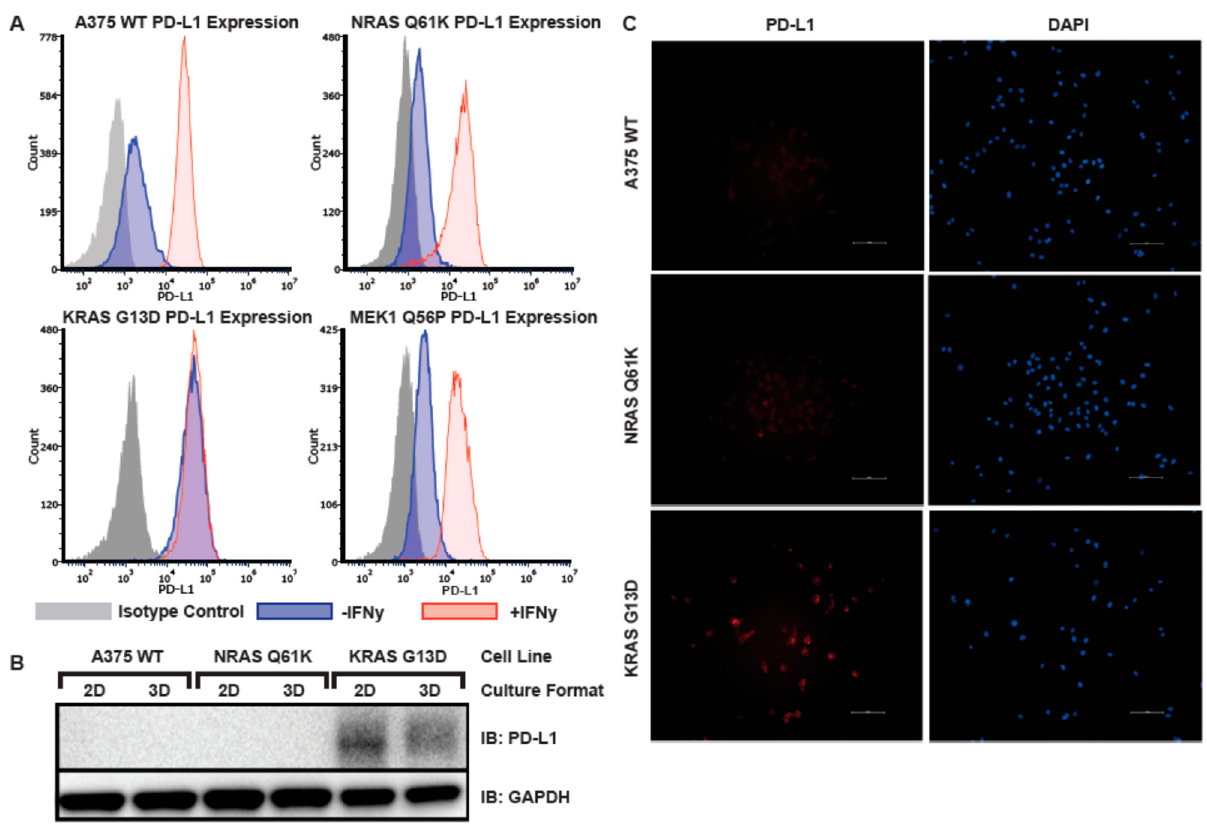
Figure 6. PD-L1 is constitutively expressed in KRAS G13D, but not in A375 WT, NRAS Q61K, or MEK1 Q56P melanoma models. ( A ) Flow cytometry analysis of cell surface PD-L1 expression in A375 WT, NRAS Q61K, KRAS G13D, and MEK1 Q56P melanoma models grown in 2D tissue culture. Cells were treated overnight with 200 ng/ μ L interferon gamma (red), or mock treated (blue). The following day the cells were stained with either anti-PD-L1 or isotype control (grey); ( B ) PD-L1 immunoblot of total cellular protein from A375 WT, NRAS Q61K, and KRAS G13D cells grown in either 2D or 3D tissue culture; ( C ) Indirect immunofluorescence staining of PD-L1 in A375 WT, NRAS Q61K and KRAS G13D melanoma model lines.